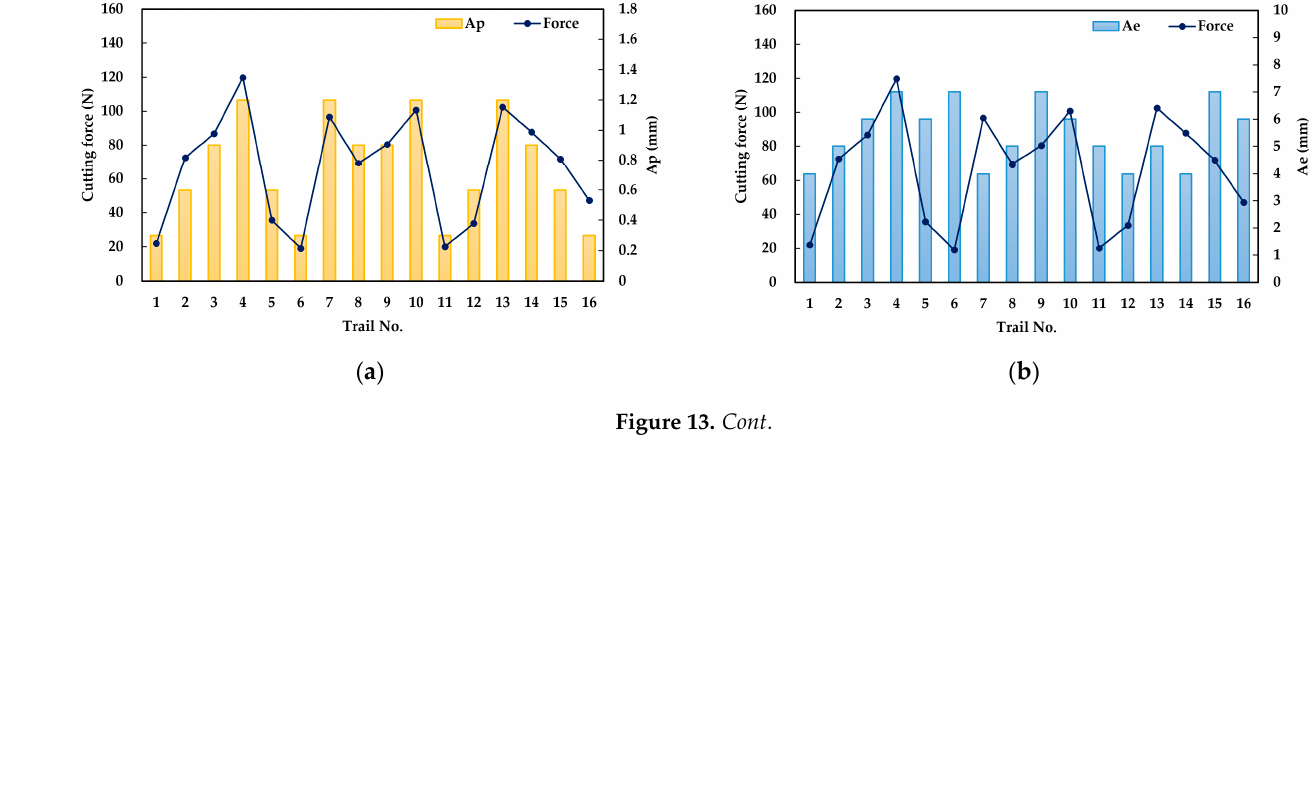
Figure 12. Deformation and surface roughness with the optimized experimental factor A1B1C1D4E4. ( a ) Max = 0.267 mm. ( b ) Max = 0.254 mm. ( c ) Ra = 0.261 μ m. ( d ) Ra = 0.291 μ m.